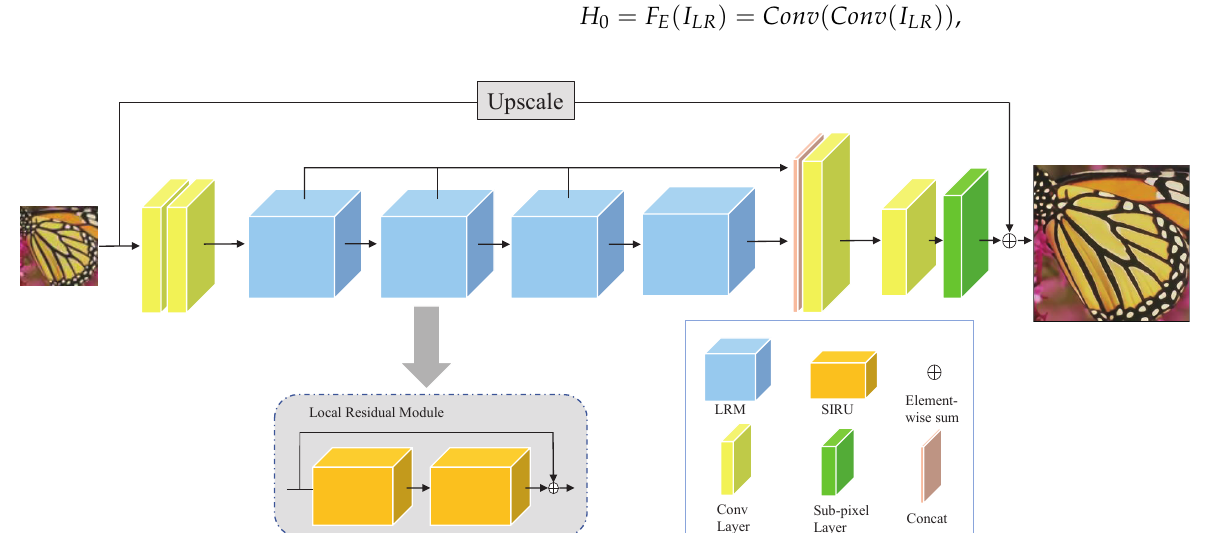
Figure 2. Network structure of proposed efficient feature generating network